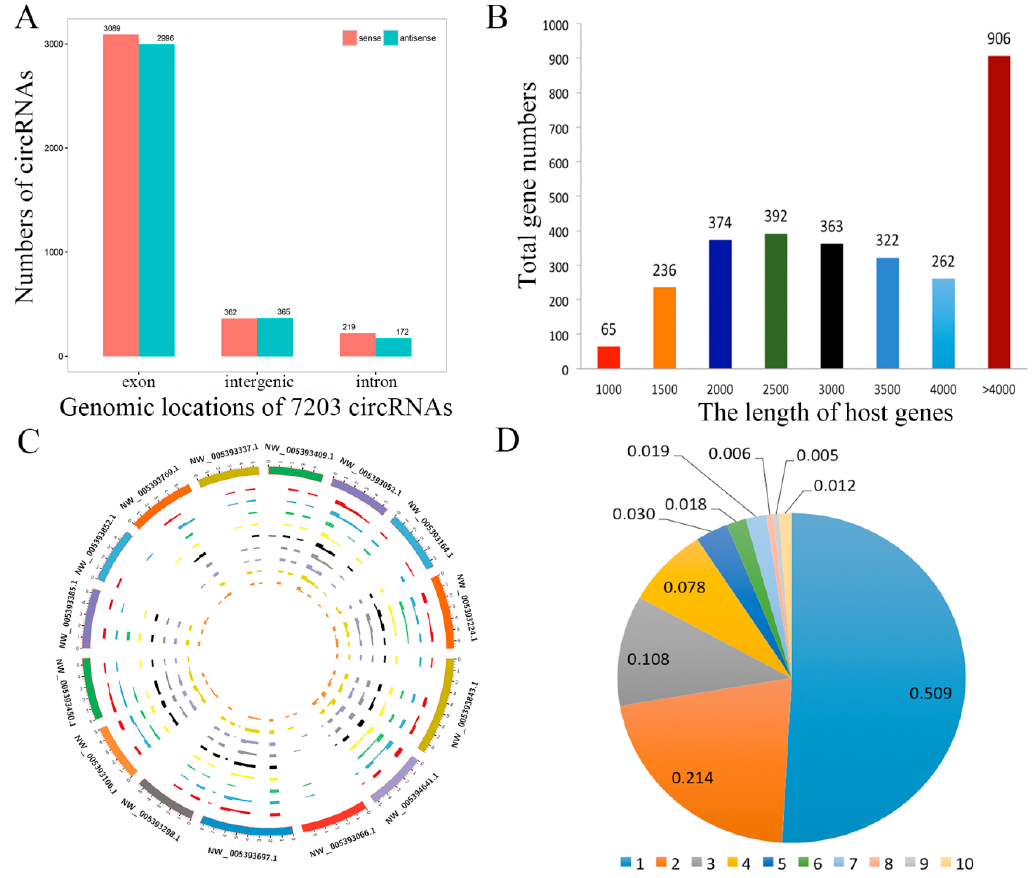
Figure 3. Profiling of circRNAs during yak adipocyte differentiation. ( A ) Distribution of circRNAs in the yak genome. ( B ) The length of host genes of circRNAs. ( C ) Circos plot showing the distribution of circRNAs in different chromosomes. ( D ) Numbers of circRNAs produced by the same gene.